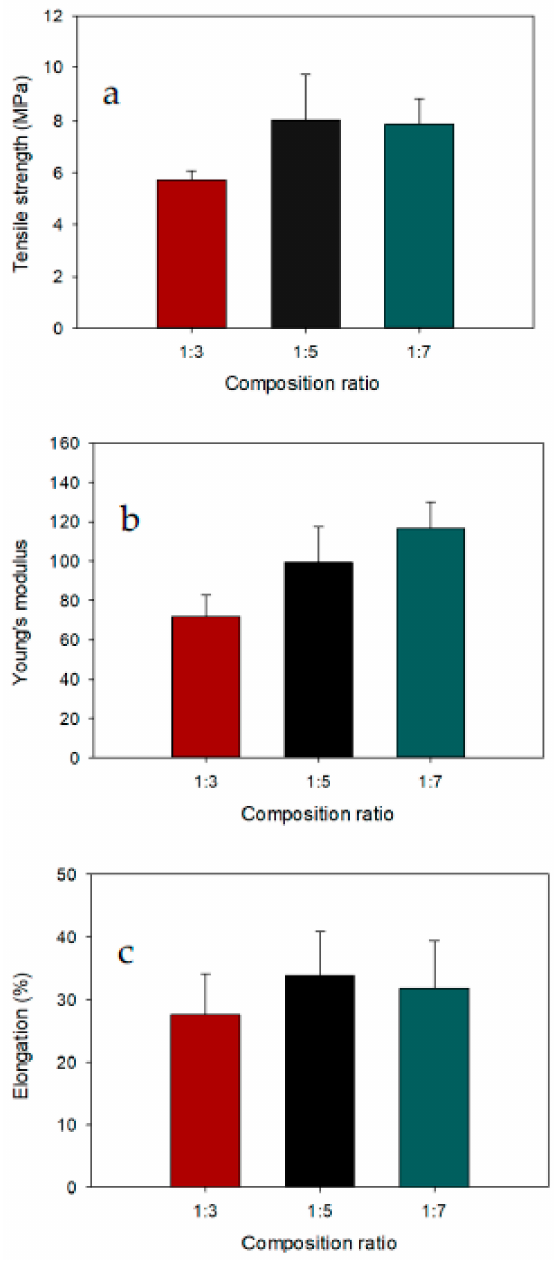
Figure 2. ( a ) Tensile strengths, ( b ) Young’s modulus, and ( c ) elongations at break (%) of modified chitosan–gelatin membrane foam with different chitosan:gelatin composition